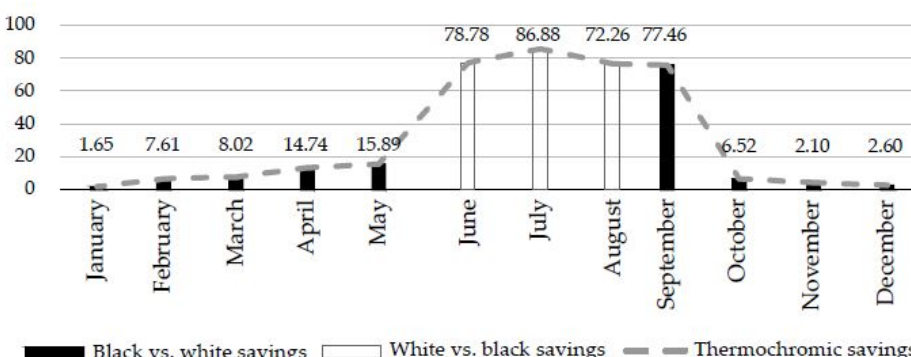
Figure 7. Monthly energy savings for the NBE-79 case with black, white, and thermochromic surface finishes in the Barcelona CZ.